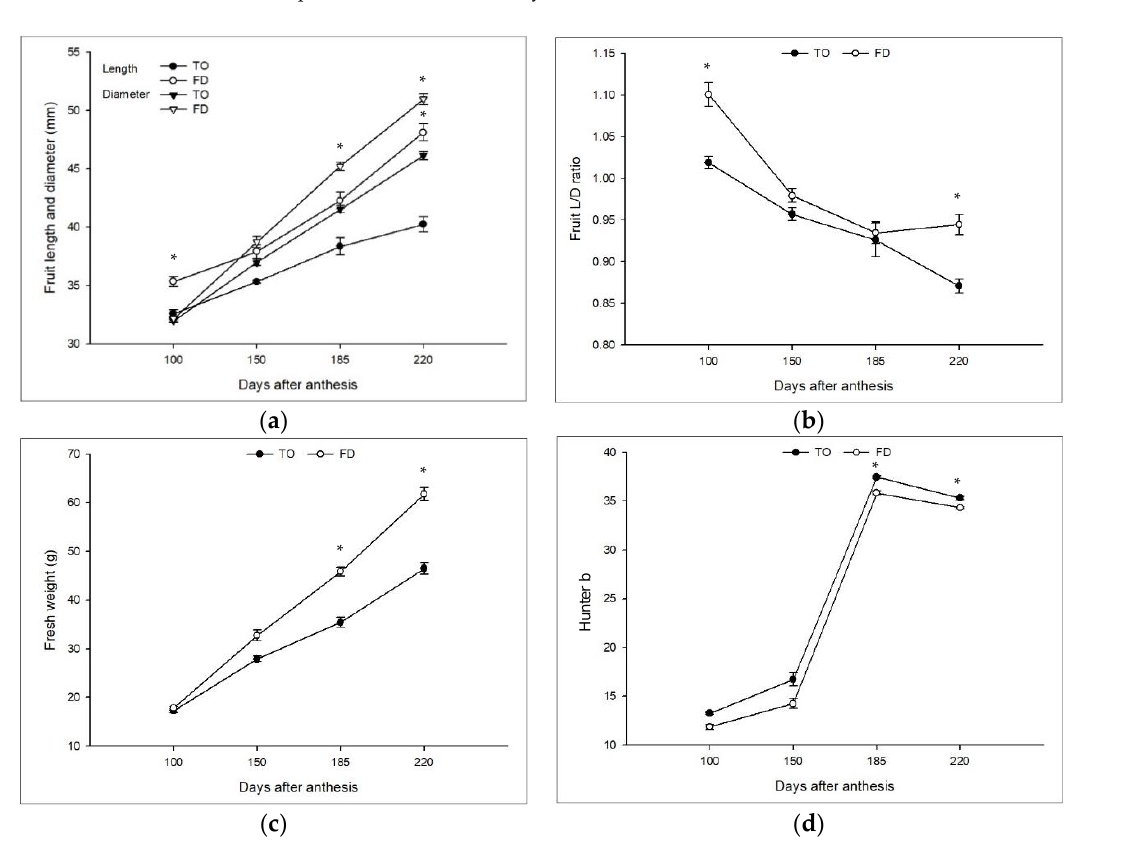
Figure 1. Changes of fruit length (L) and diameter (D) ( a ), L/D ratio ( b ), fruit weight ( c ) and rind coloration ( d ) during the fruit development in ‘Minihyang’ mandarin grafted on trifoliate orange (TO) and Frying Dragon (FD) rootstocks. * Mean separation within columns by T-test at 5% level. The rootstocks affected the SSC and TA of fruits in “Minihyang” mandarin. FD rep- resented higher SSC than TO with a range of 0.6–1.1° Brix during all fruit developmental stages (Figure 2). However, TA represented some different patterns to SSC despite higher TA on FD during all fruit developmental stages, and there was little difference except an apparent difference with 1.1% at an initial enlargement stage. Rind coloration was not affected by two different rootstock genotypes of TO and FD (Figure 1d). Several studies have already reported that FD enhanced fruit quality with higher SSC and similar TA than those of TO in Satsuma mandarin [8,17,18] and sweet orange [19], which was consistent suggested that the effect of FD on higher TSS may be associated with water stress induced by FD, but it remained to be elucidated in the future